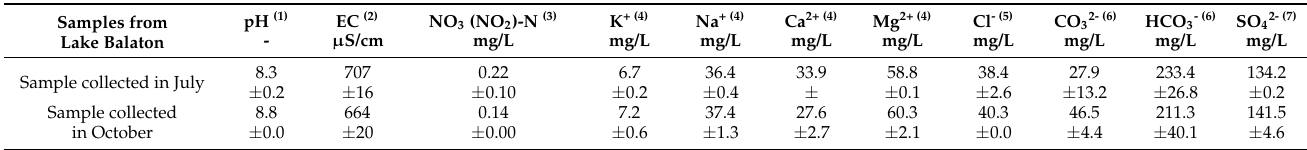
Table 1. Characteristics of freshwater samples from Lake